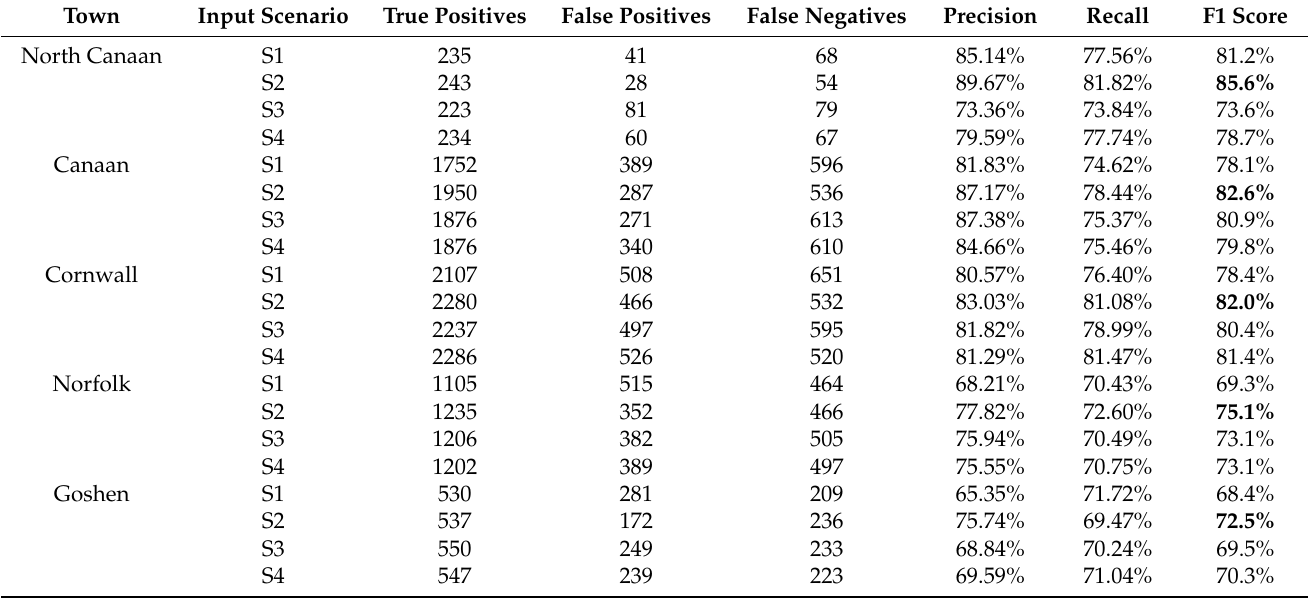
Table 5. The results for the entire test region after post-processing. For Cornwall Town, accuracy was calculated without including train region. Bold text represents the highest F1 score in each town.